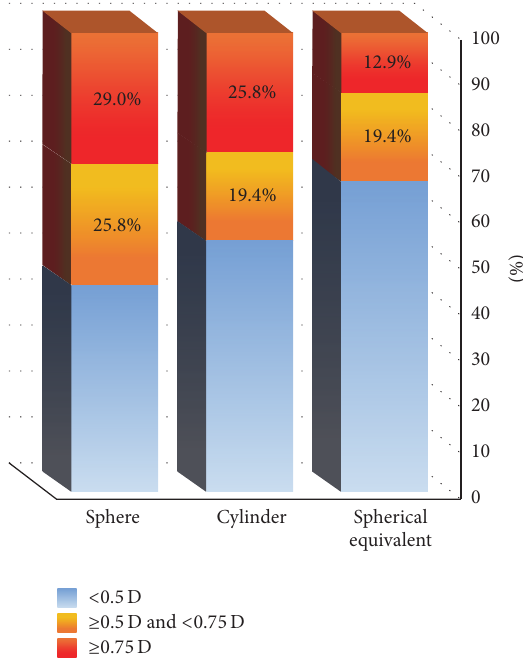
Figure 2: Proportion of cases in which the surgically induced change in refraction was clinically